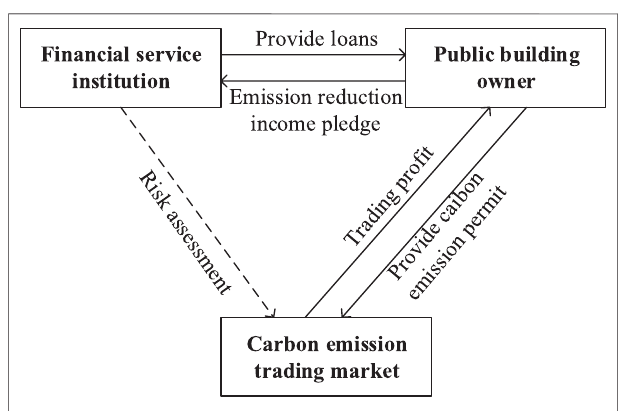
FIGURE9| Patternofdispersingcarbon-emissionreduction investment and transaction risk of fi nancial institutions.